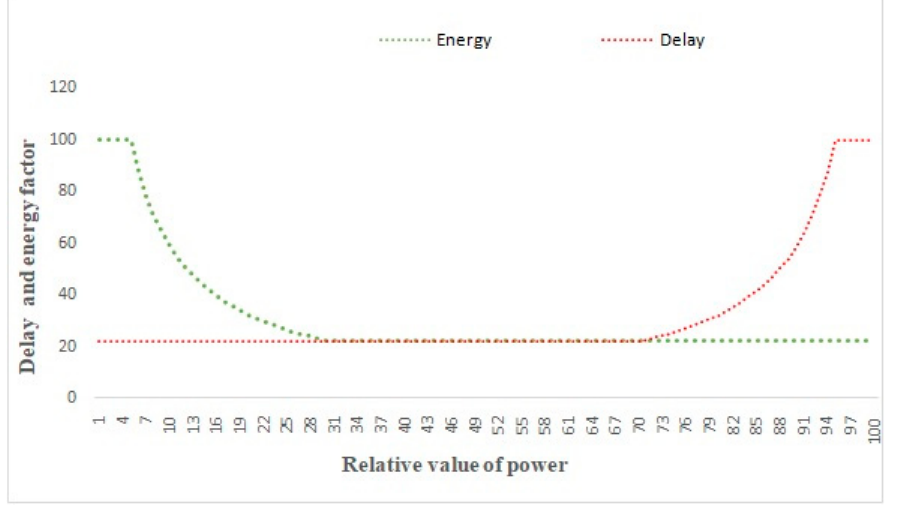
Figure 7. Time delay and energy consumption factors at different power values.